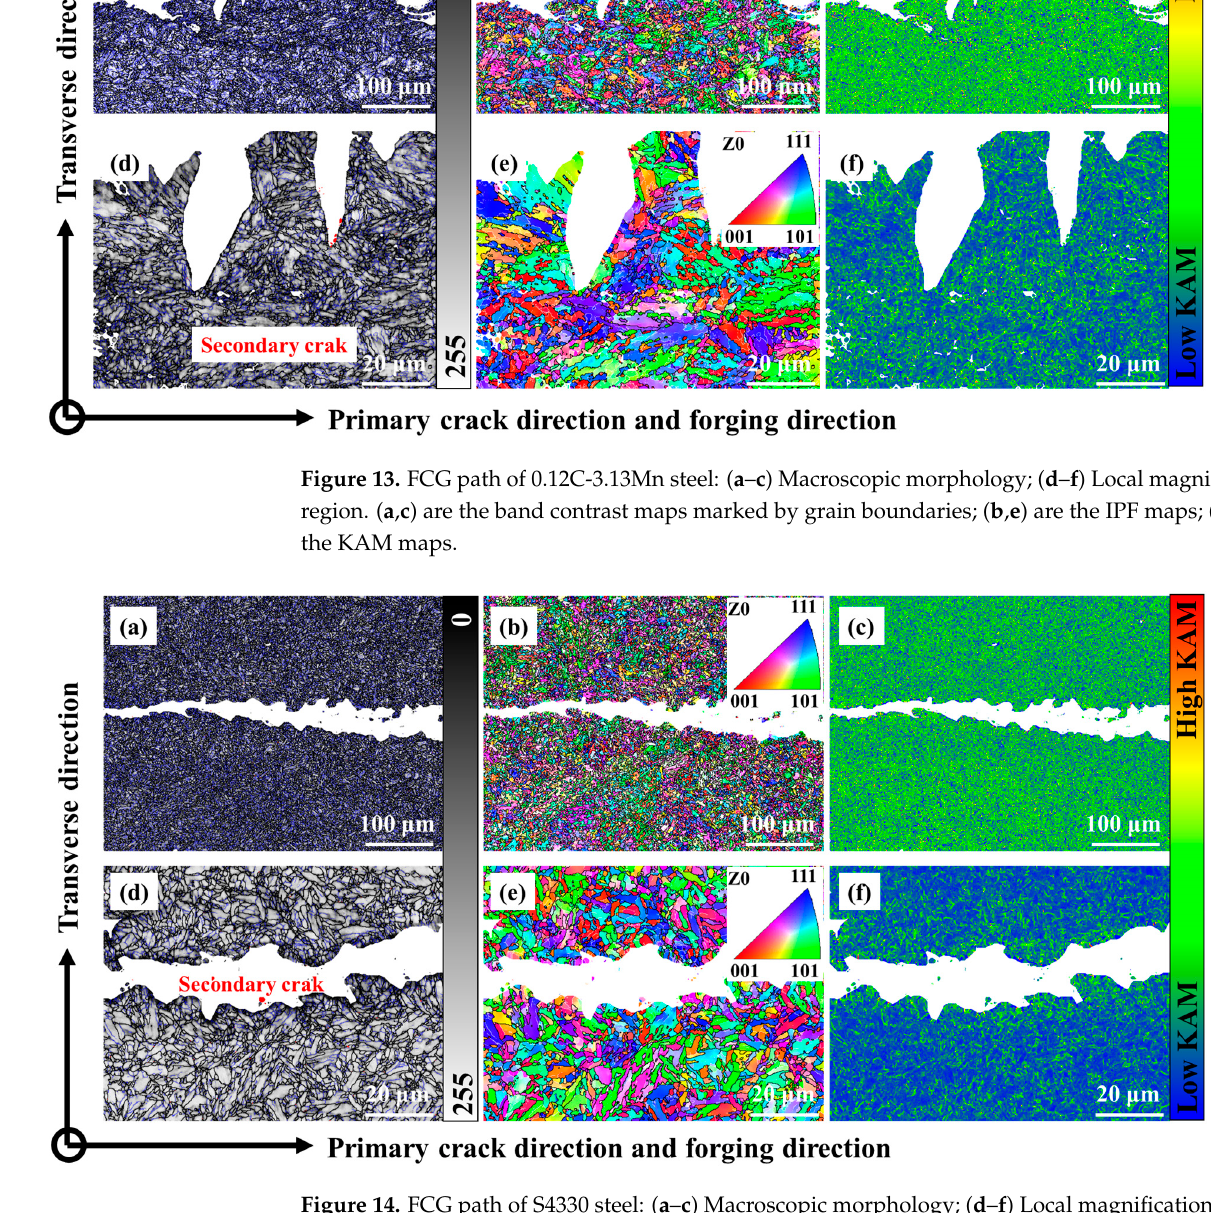
Figure 14. FCG path of S4330 steel: ( a – c ) Macroscopic morphology; ( d – f ) Local magnification region. ( a ) and ( c ) are the band contrast maps marked by grain boundaries; ( b ) and ( e ) are the IPF maps; ( c ) and ( f ) are the KAM maps.